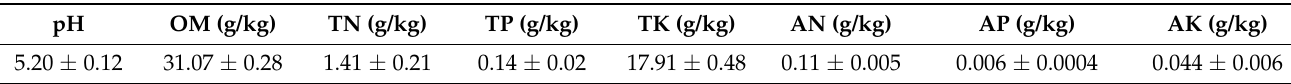
Table 2. Background values of nutrients in the experimental soil in the suburb of Shanghai, Southeast China. Data are means ± SD, n = 3.